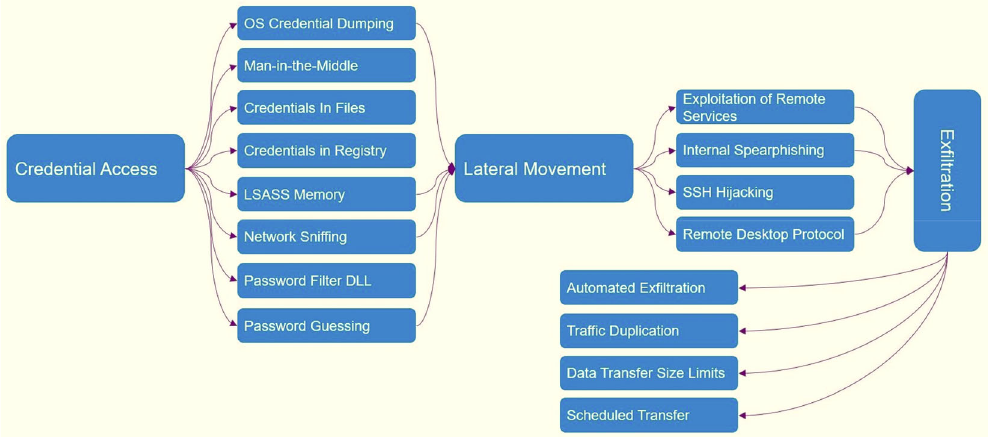
Figure 11. Windows defender, and firewall cannot detect the